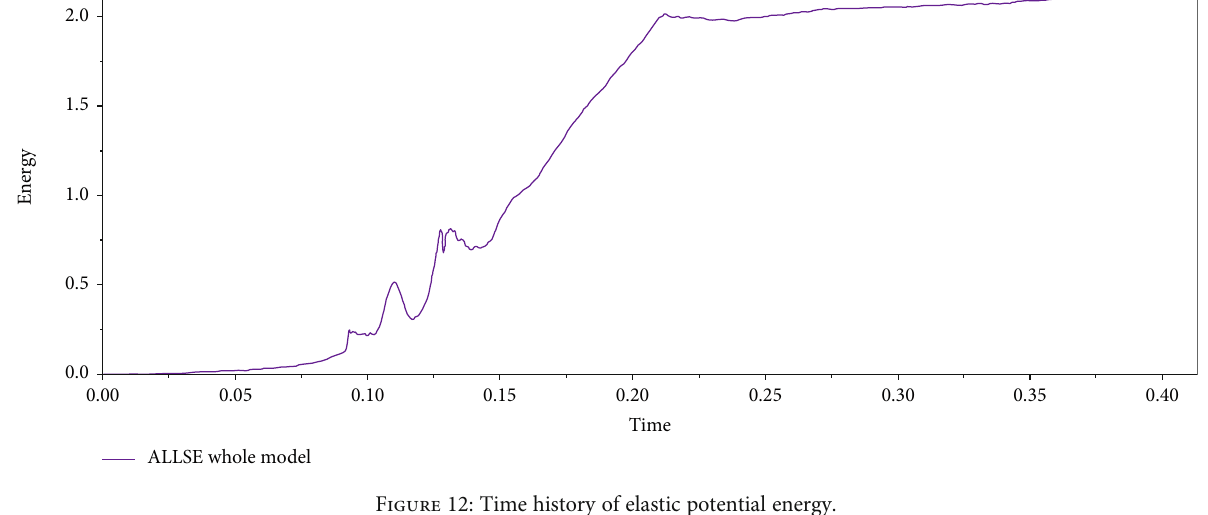
Figure 12: Time history of elastic potential energy.